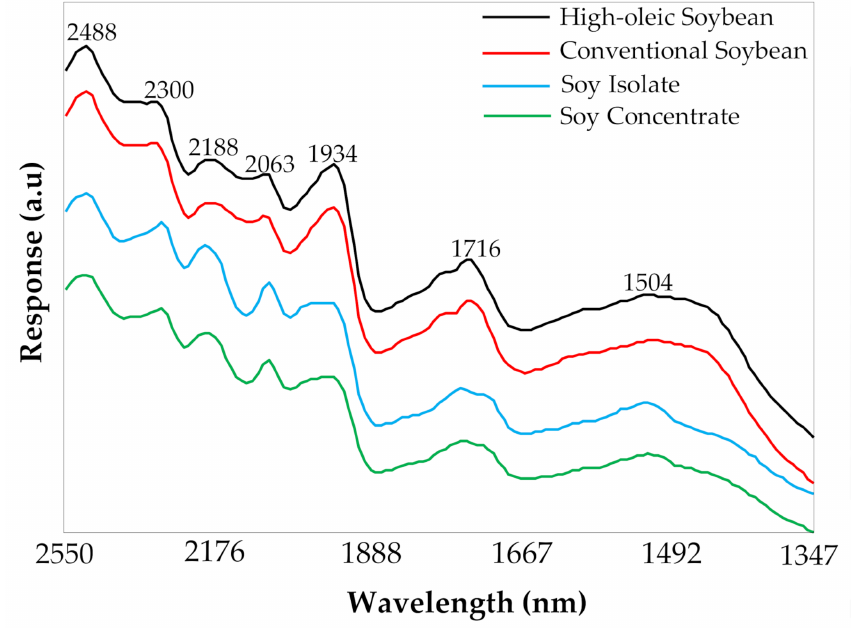
Figure 2. Raw NIR spectra of ground soybeans (high-oleic and conventional varieties), soy isolate, and soy